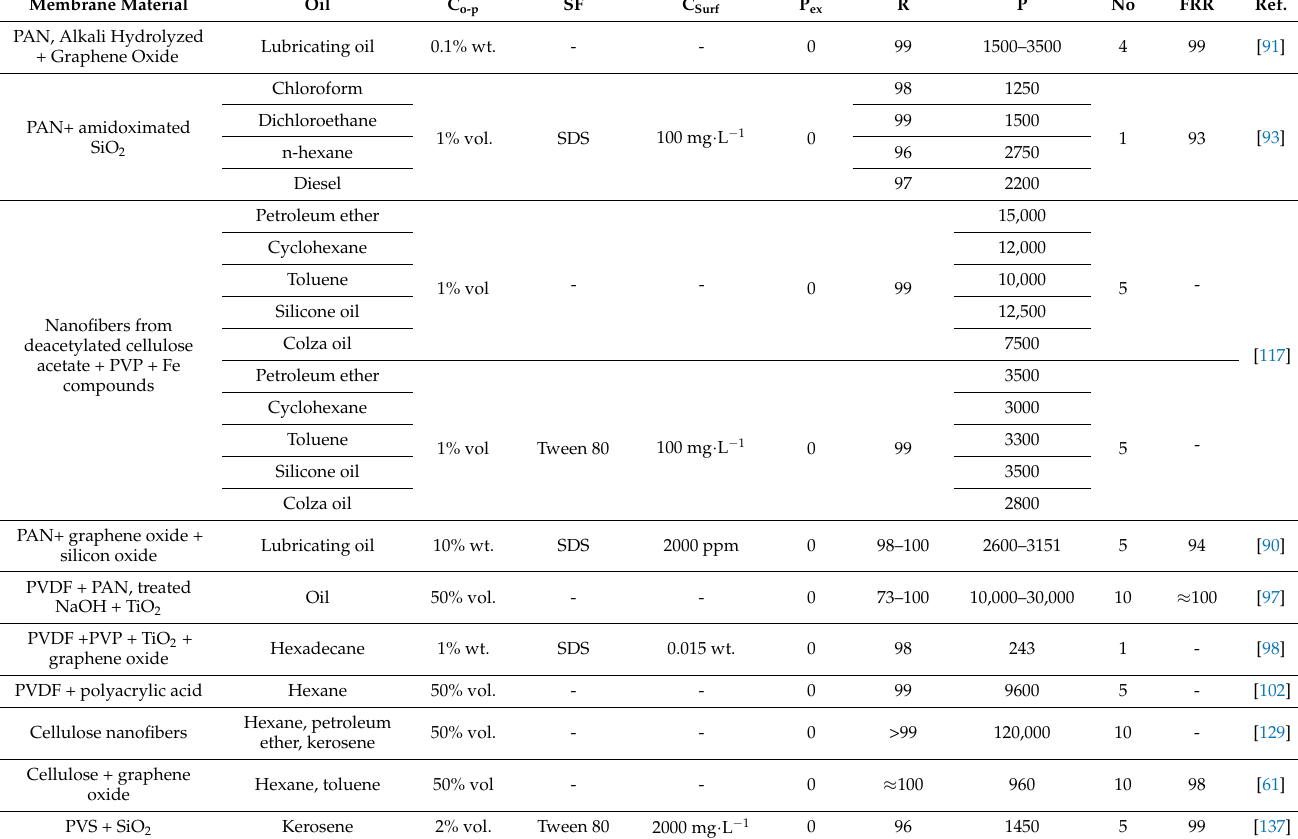
Table 8. Membranes formed by electrospinning for the separation of oil-in-water